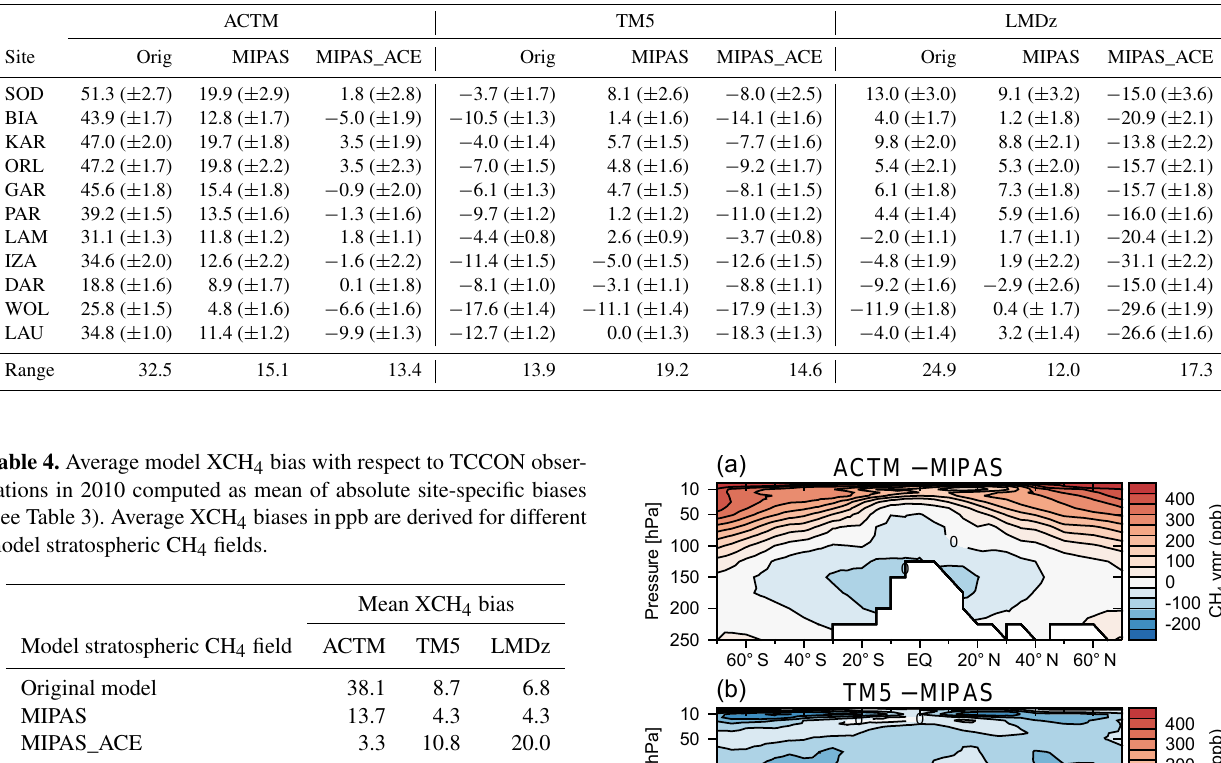
Table 3. Site-specific model XCH 4 biases with respect to TCCON observations in 2010. The model–TCCON agreement in XCH 4 is evaluated with different stratospheric CH 4 model fields: the original model distribution (orig), the MIPAS-based stratospheric CH 4 (MIPAS), and the MIPAS-based stratospheric CH 4 adjusted to ACE-FTS observations (MIPAS_ACE). XCH 4 biases and corresponding 2 σ standard errors (in brackets) are in parts per billion (ppb).